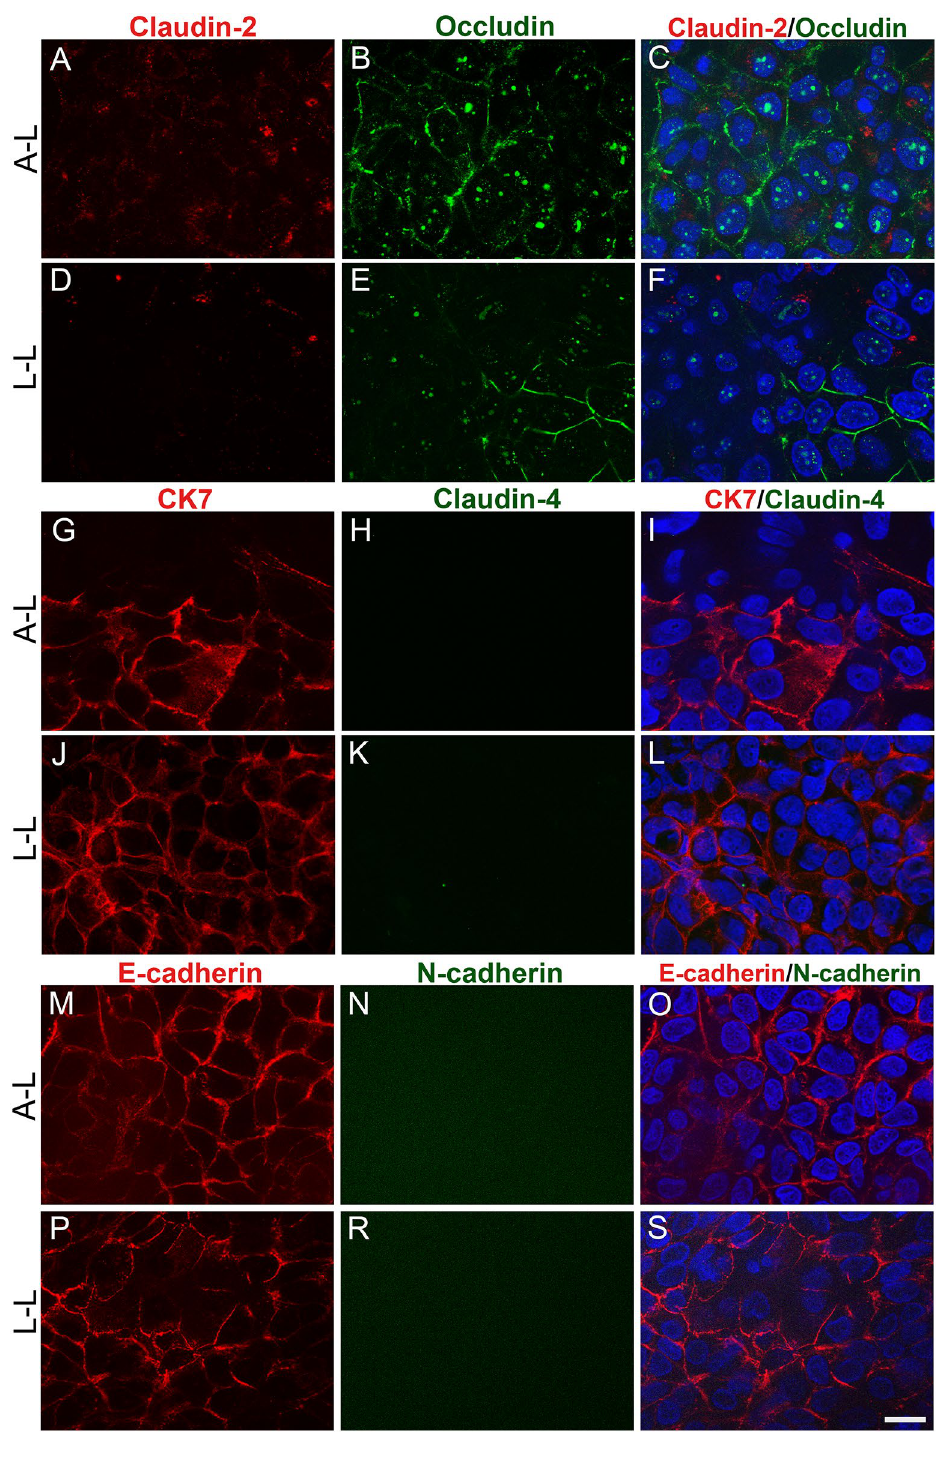
Figure 8. Expression of junctional proteins and cytokeratin-7 (CK-7) in short-term FLO-1 models. Cells were grown on porous membranes in A-DMEM medium at the A–L and L–L interfaces for 1 wk. Double immunofluorescence labelling of claudin-2 and occludin ( A – F ), cytokeratin 7 (CK7) and claudin-4 ( G – L ), and E-cadherin and N-cadherin ( M –S). FLO-1 cells express occludin (green, B – C , E – F ), CK7 (red, G , I , J , L ) and E-cadherin (red, M , O , P ,S) but not claudin-2 ( A , D ), claudin-4 ( H , K ) or N-cadherin ( N , R ). Nuclei are stained blue. Scale bars, 20